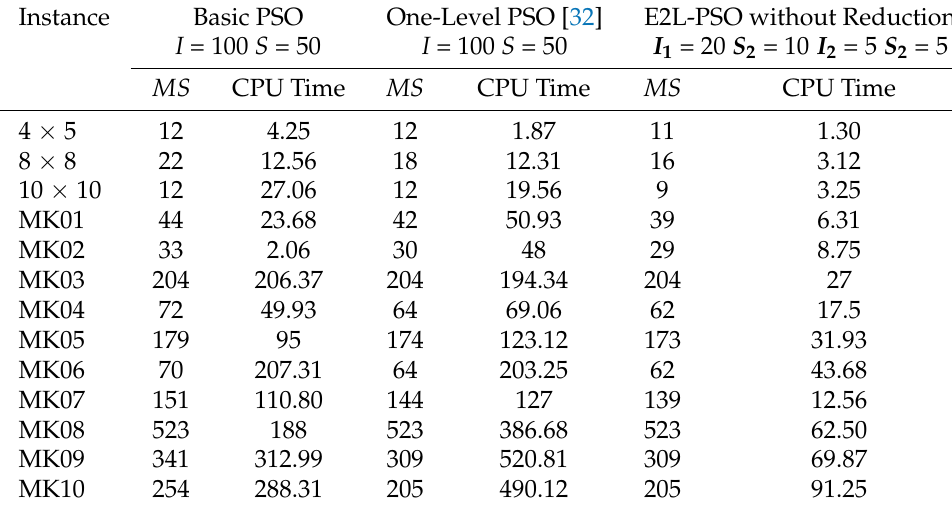
Table 7. Comparison 3 between the three developed PSO variants on STM32 F407VGT6.